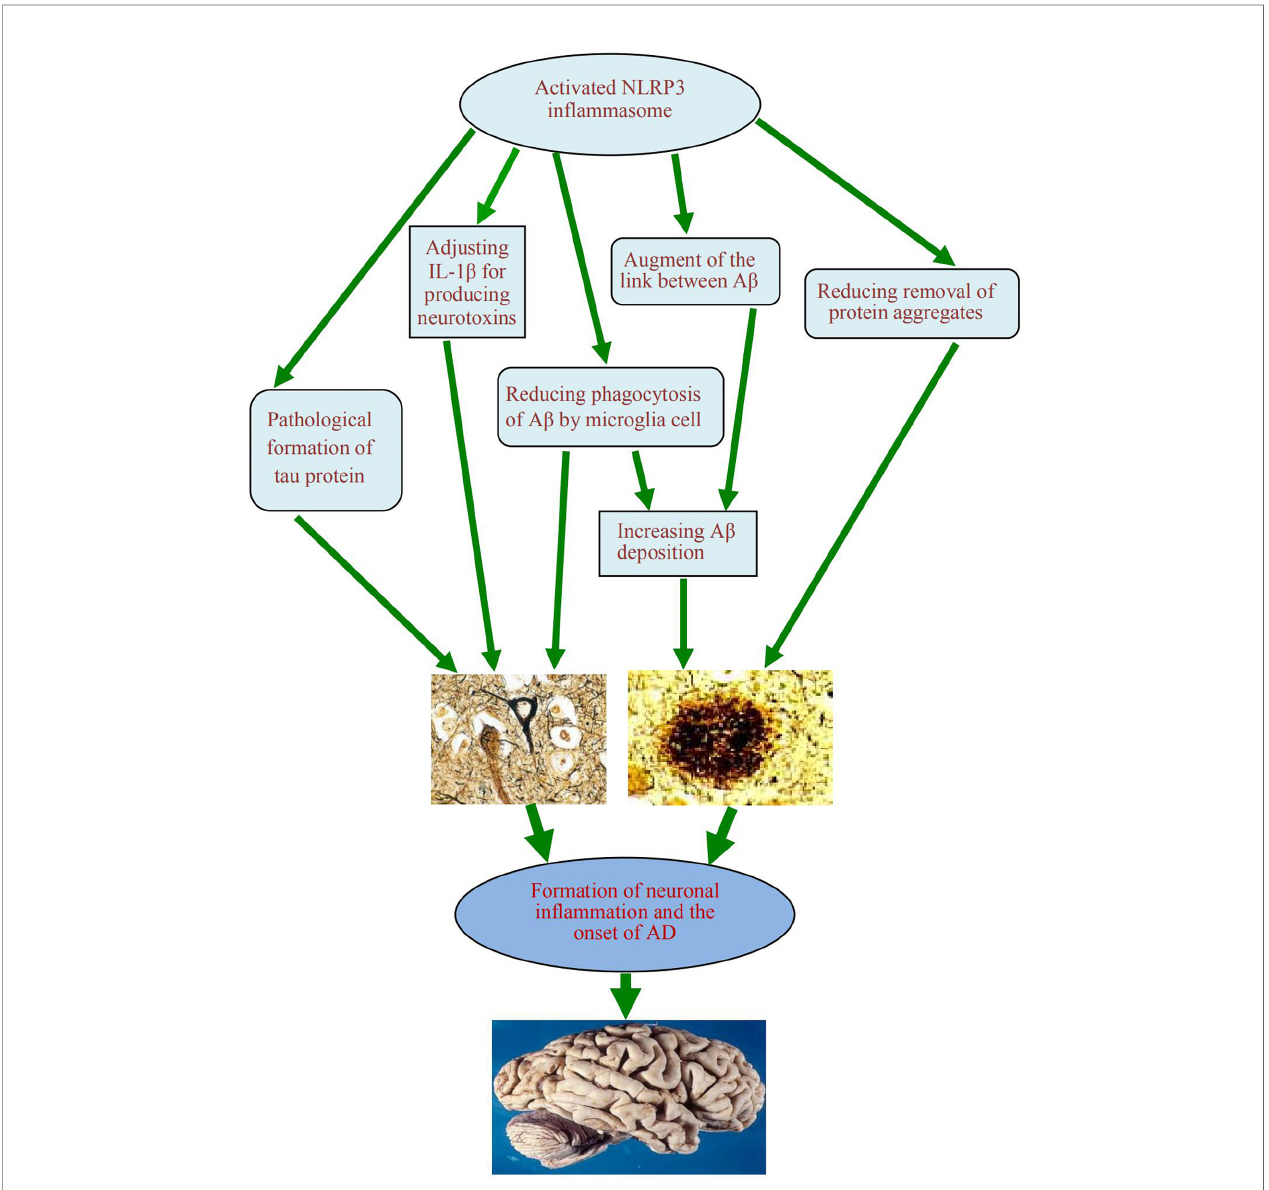
FIGURE 3 | A schematic diagram of the association between activation of NLRP3 in fl ammasome and occurrence of AD. The activated NLRP3 in fl ammasome contributes to the formation of chronic neuroin fl ammation and the pathogenesis of Alzheimer ’ s disease, which play the role by regulating the production of neurotoxin IL-1 b , reducing the phagocytosis of A b from microglia, augmenting the link between A b and A b , reducing the clearance of some excess protein aggregates, and promoting the pathological formation of Tau protein. NLRP3, nucleotide-binding domain leucine-rich repeat and pyrin domain containing receptor protein 3; AD, Alzheimer ’ s disease; IL-1 b , interleukin 1 b ; A b , b -amyloid